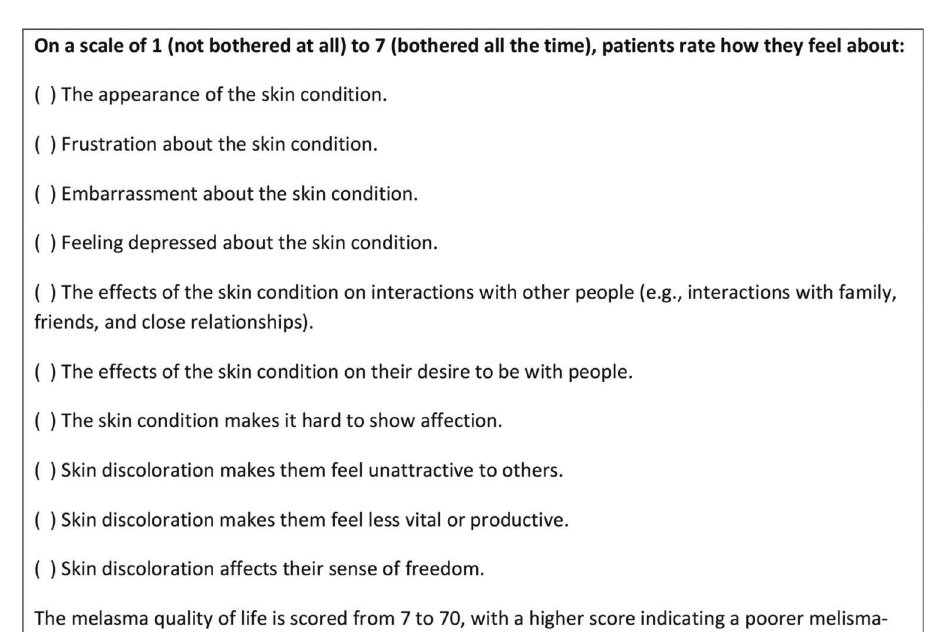
Figure 2 - MelasQoL